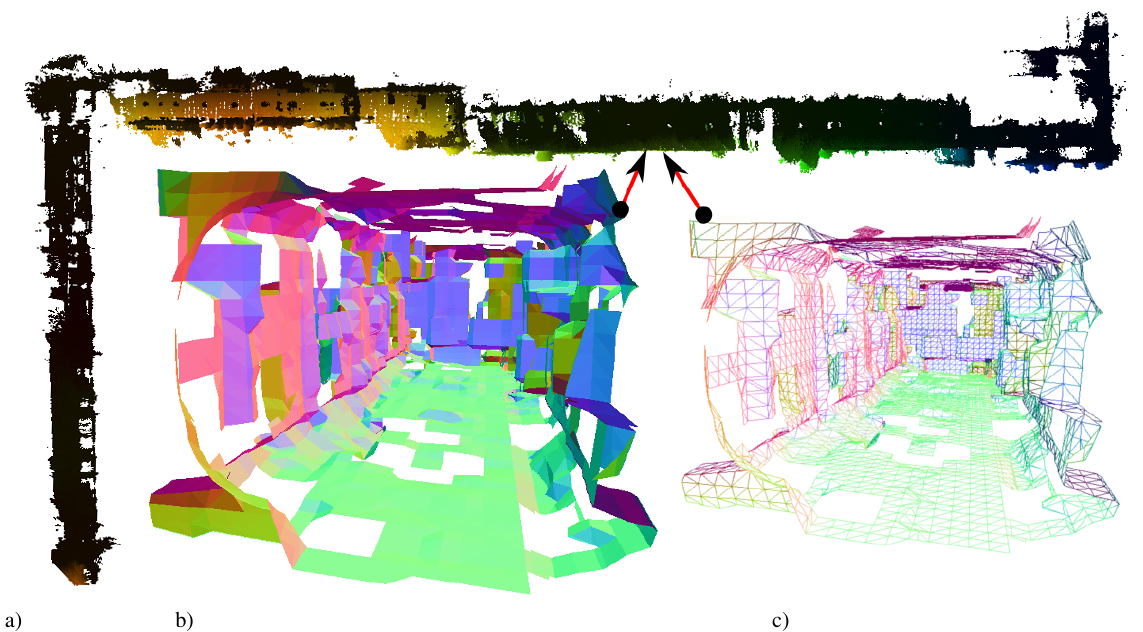
Figure 5: Reconstruction results from a part of the large corridor dataset. The part is marked with two red lines on the top. The proposed method recovered the structure of the corridor successfully despite of reflecting floor and overexposed wall decorations. a) Top view of the raw point cloud which has been acquired by a mobile depth sensor. b) Triangulated result rendered with non transparent meshes. c) Wire frame view of the same part of the